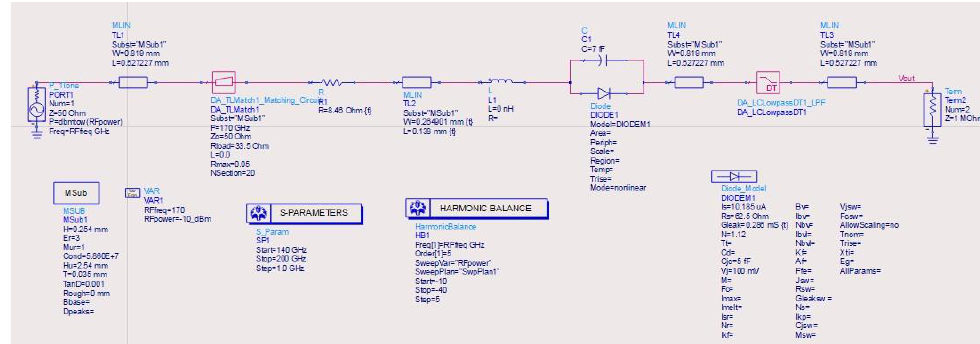
Figure 9 : The detector circuit and harmonic balance simulation configuration.